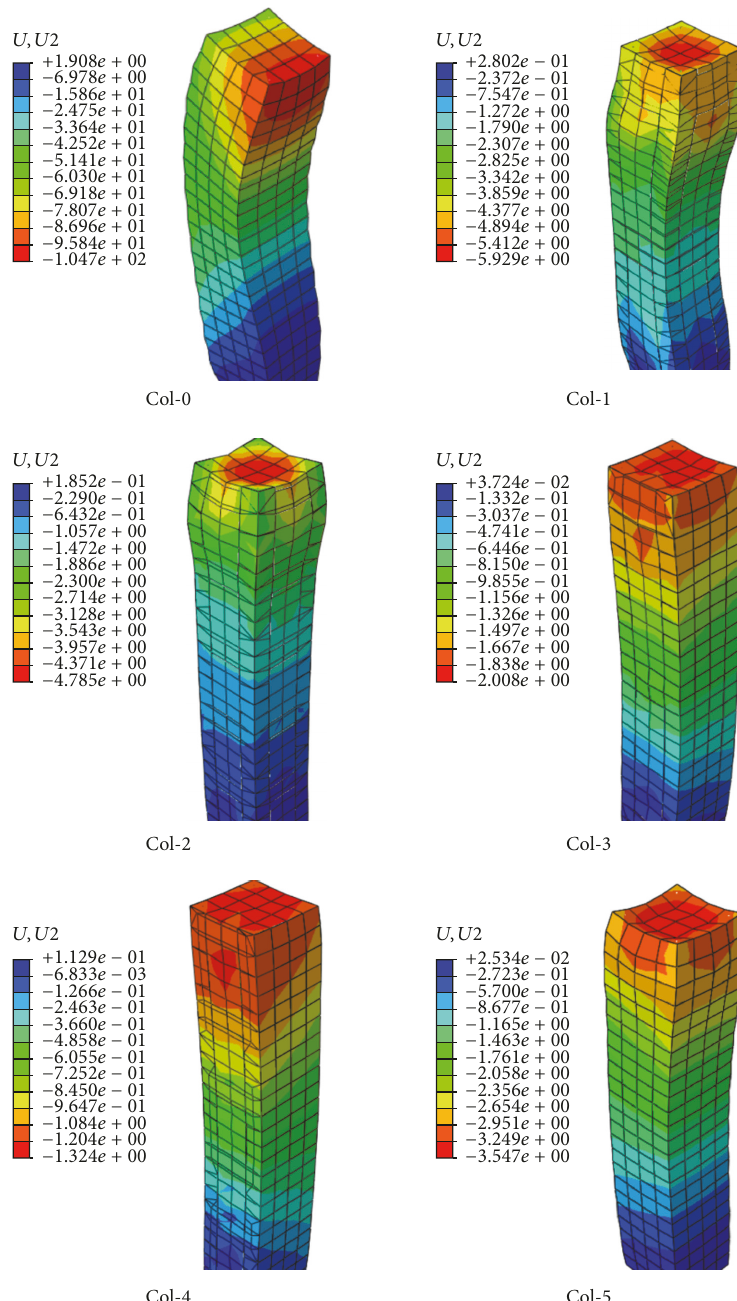
Figure 22: Deformation of damaged columns at failure